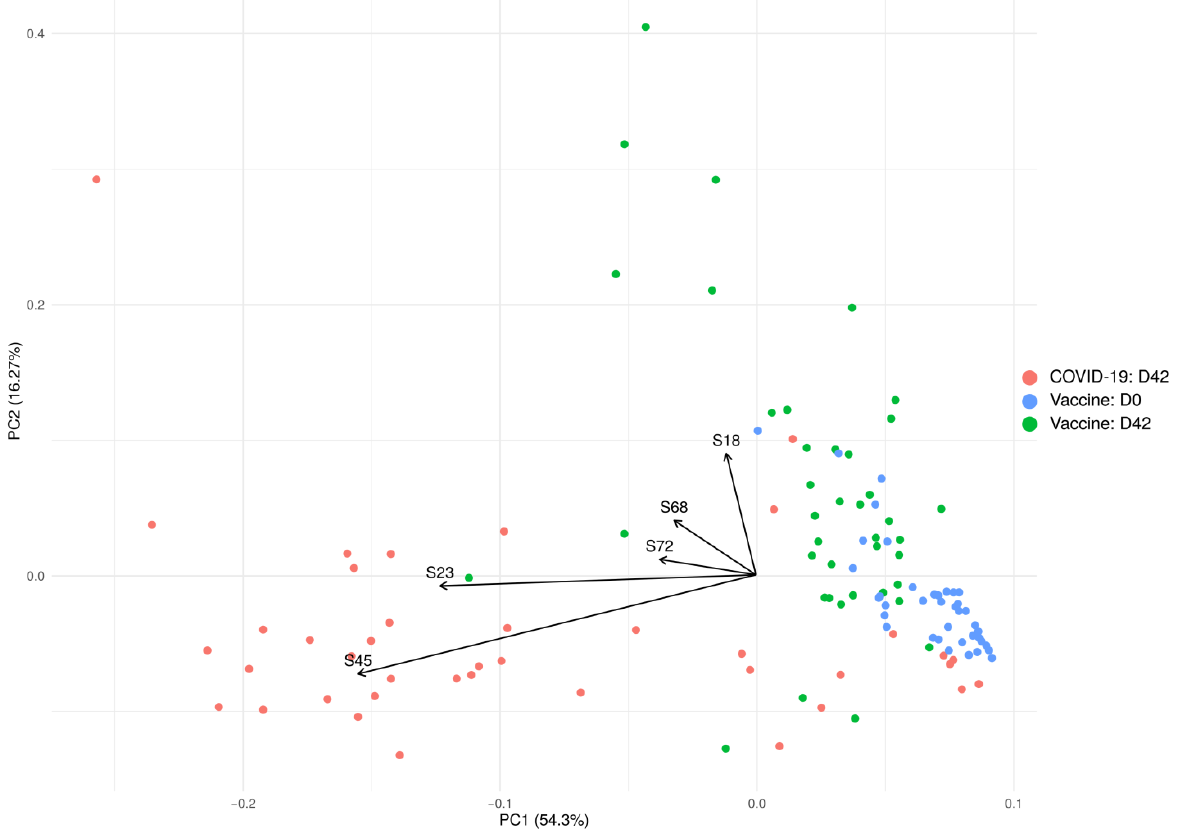
Figure 3. PCA based on the levels of anti-SARS-CoV-2 antibodies in SputnikV vaccinated and convalescent COVID-19 sera. The top five variables (arrows) with the highest contribution are presented. PCA reduces the dimension of multidimensional data (46 peptides) to two (2 axis — PC1 and PC2), which could be visualized with minimal loss information.